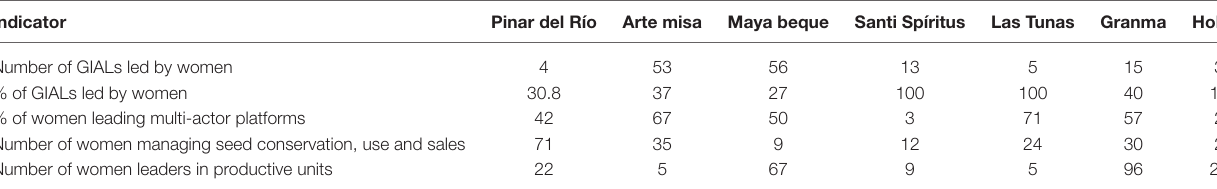
Number of women leaders in productive